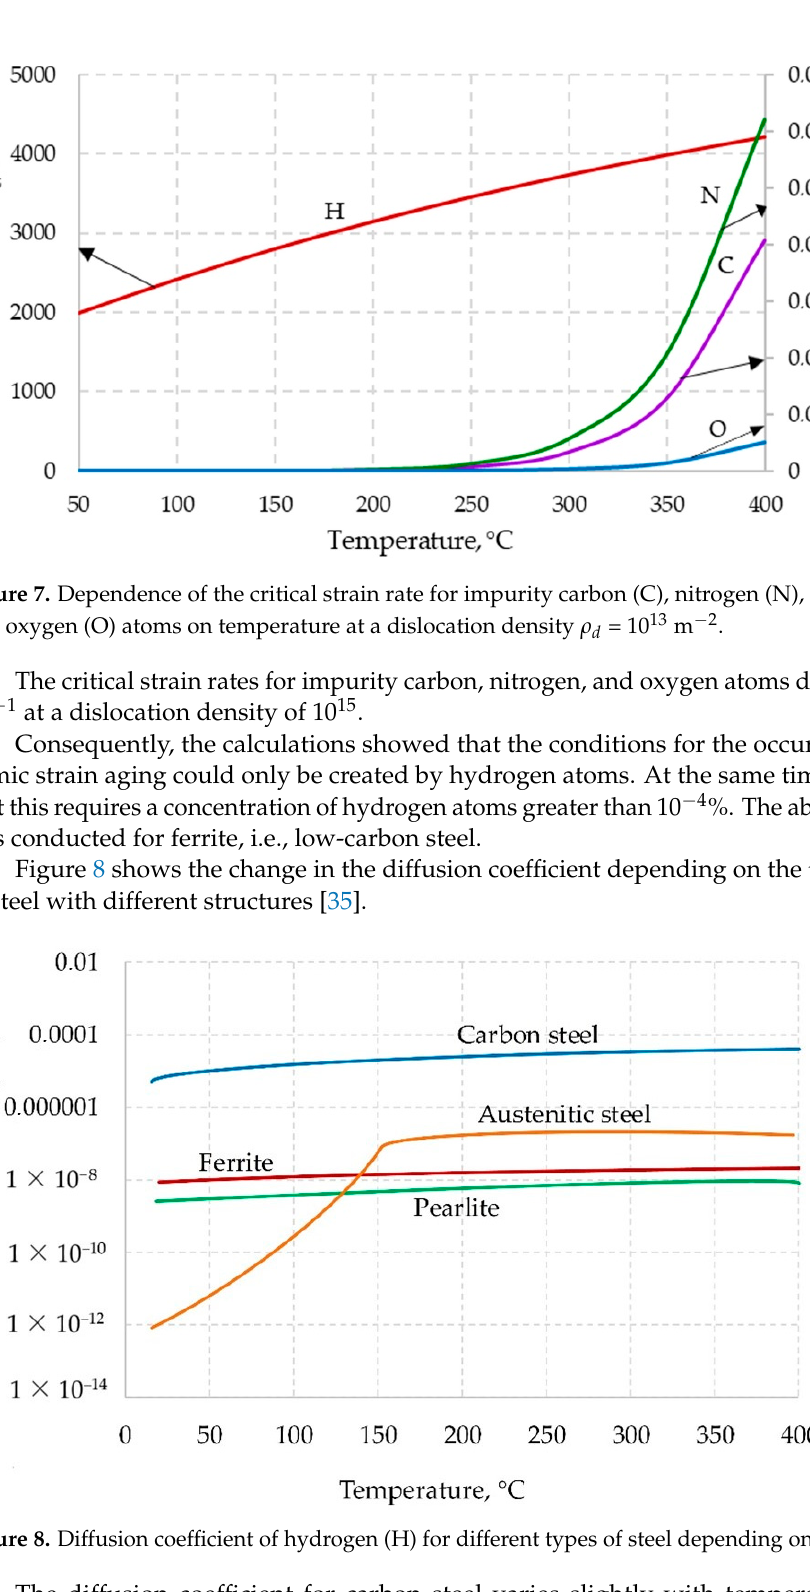
Figure 8. Diffusion coefficient of hydrogen (H) for different types of steel depending on tempera- ture.